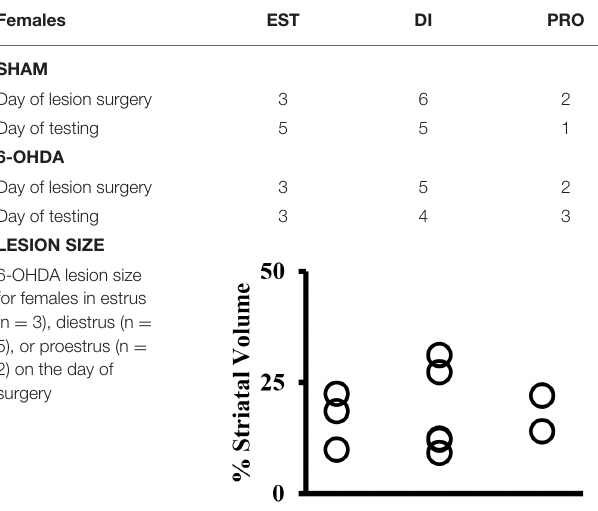
Below: Scatter plots showing the volumes of 6-OHDA lesions, expressed as percent of total caudate nucleus volume, for female rats that were identified as being in EST, DI, or PRO on the day of surgery.